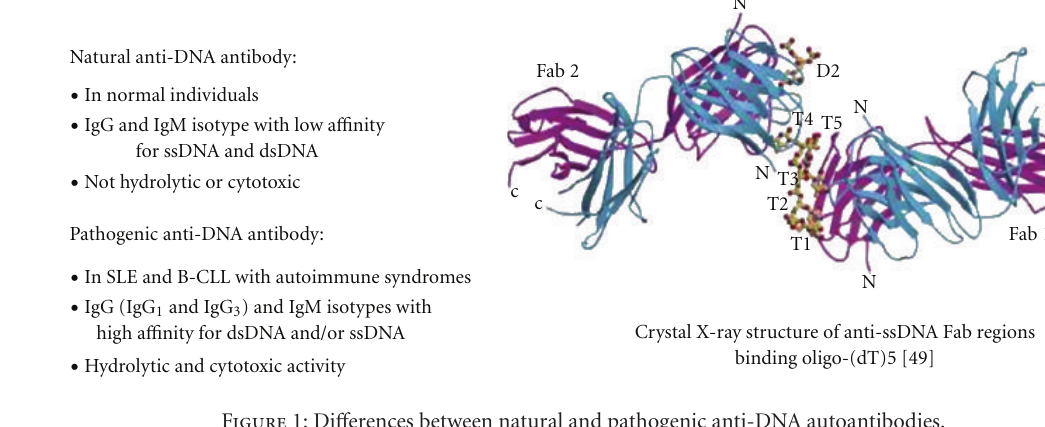
Figure 1: Di ff erences between natural and pathogenic anti-DNA autoantibodies.